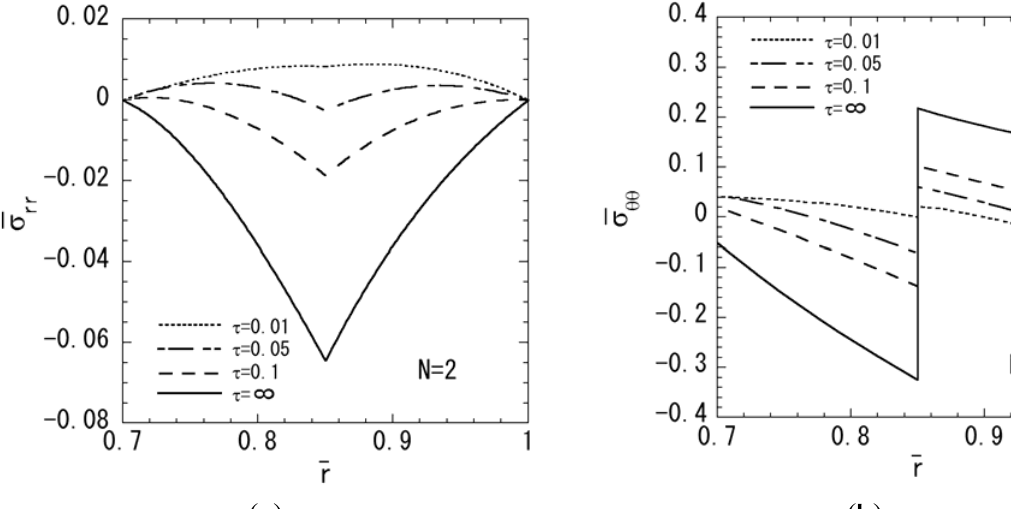
Figure 9. Numerical results for the two-layered hollow sphere ( 2 = N ): ( a ) normal stress σ ; ( b ) normal rr